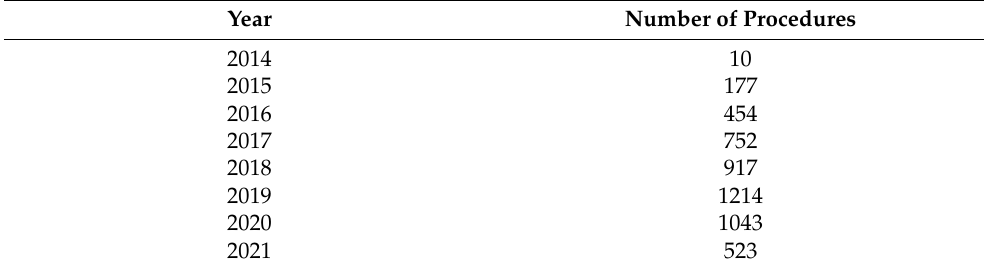
Table 3. Number of sedations per year from initiation onwards.